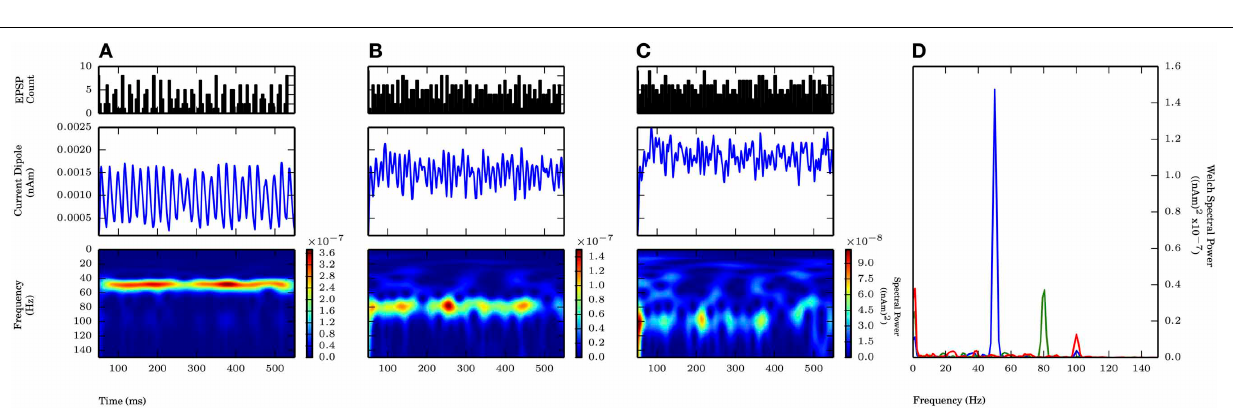
(A) . Max. P W of 3.7 × 10 − 8 (nAm) 2 at 80.6Hz (green in D). (C) f prox = 100Hz: Less consistent band of activity at 100Hz, compared to 50Hz (A) and 80Hz (B) . P W of 1.3 × 10 − 8 (nAm) 2 at 100.1Hz (red in D). (D) Welch periodogram of current dipole in (A) (shown in blue), (B) (green), and (C) (red) demonstrates reduction in P W as f prox was